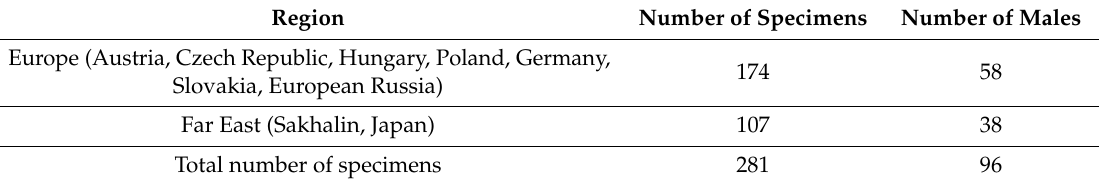
Table 1. Material